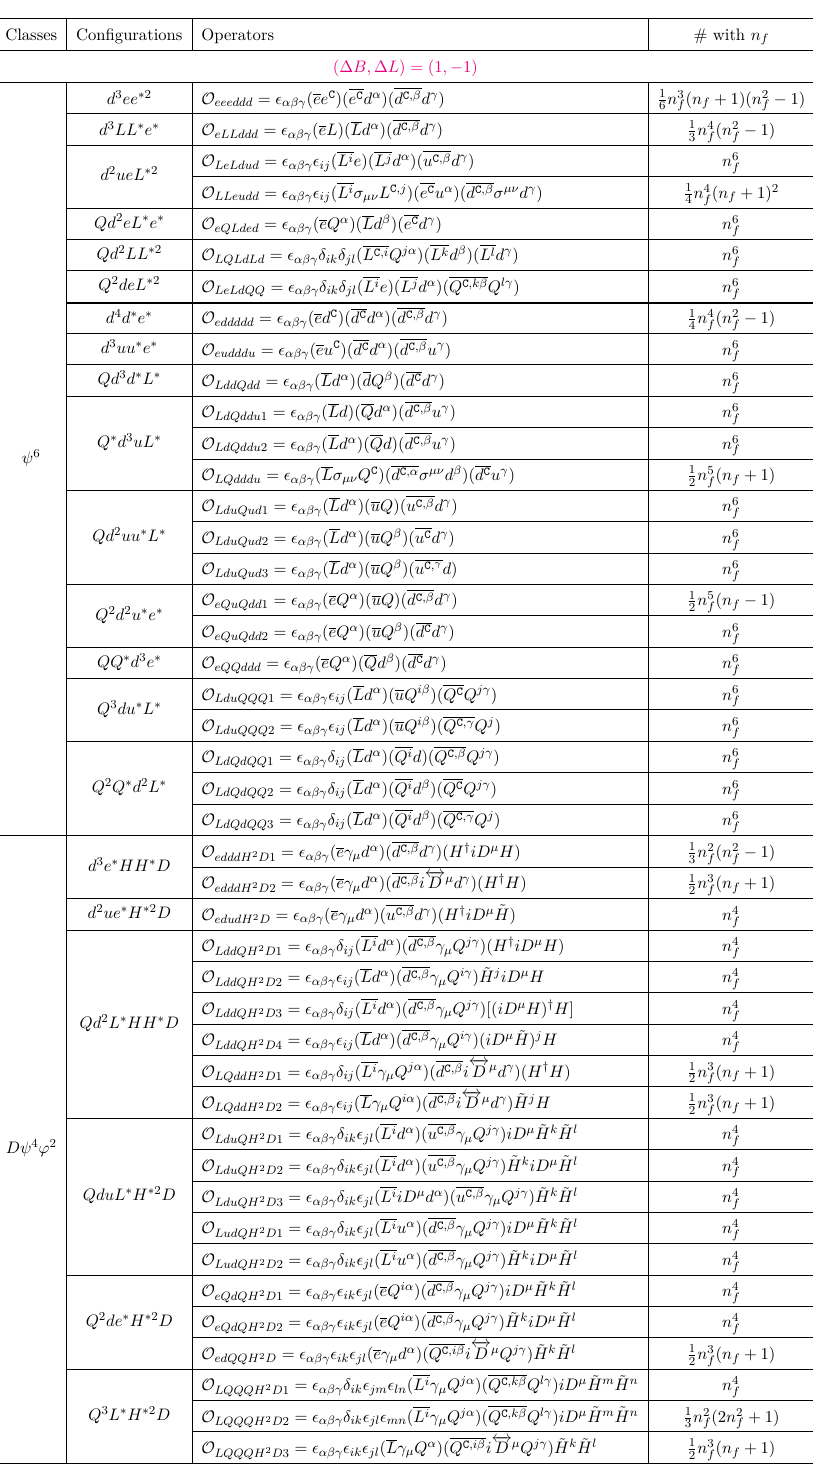
Table 8 . Dim-9 operators in classes ψ 6 , Dψ 4 ϕ 2 for sector (∆ B, ∆ L ) = (1 , − 1) . There are 44 operators without counting fermion generations and 39 remain for one generation case. The SU(3) C contraction with δ αβ is implied in class ψ 6 class. Hermitian conjugated operators are not included or